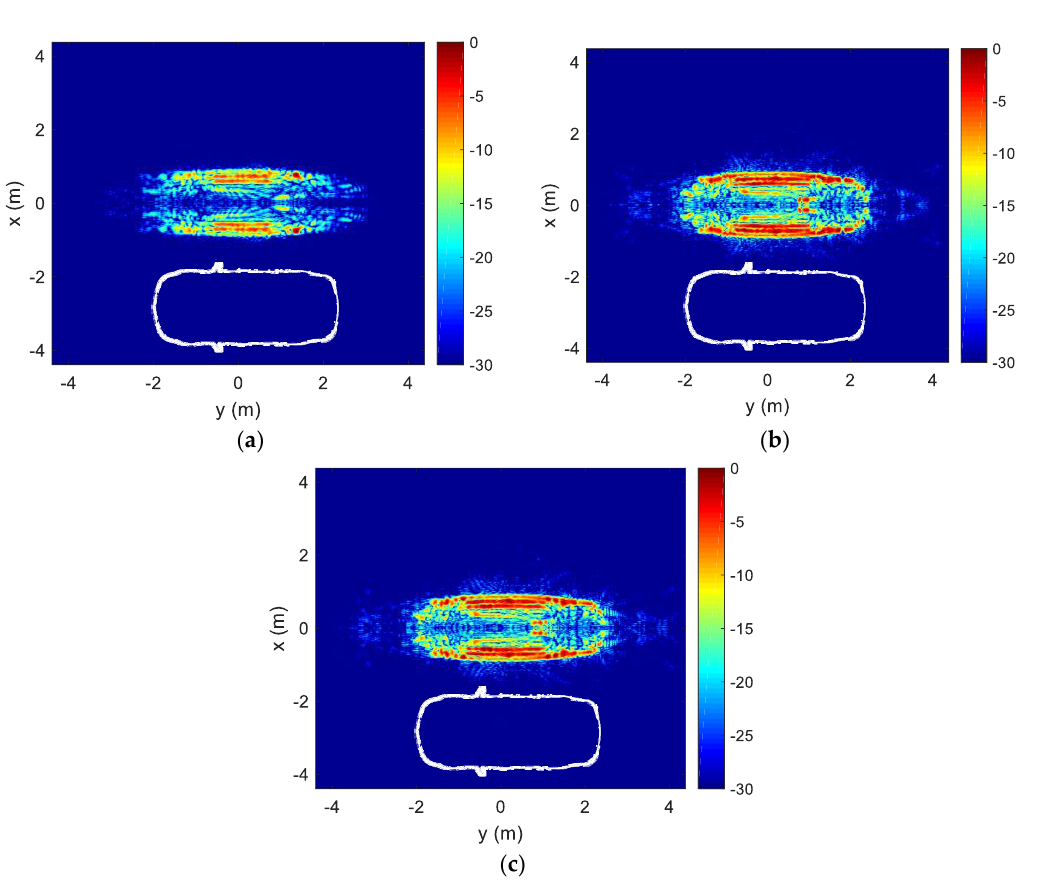
Figure 3. Vehicle ISAR images: ( a ) After coarse motion compensation; ( b ) After fine motion compensation; ( c ) After motion compensation using ranging radio data.